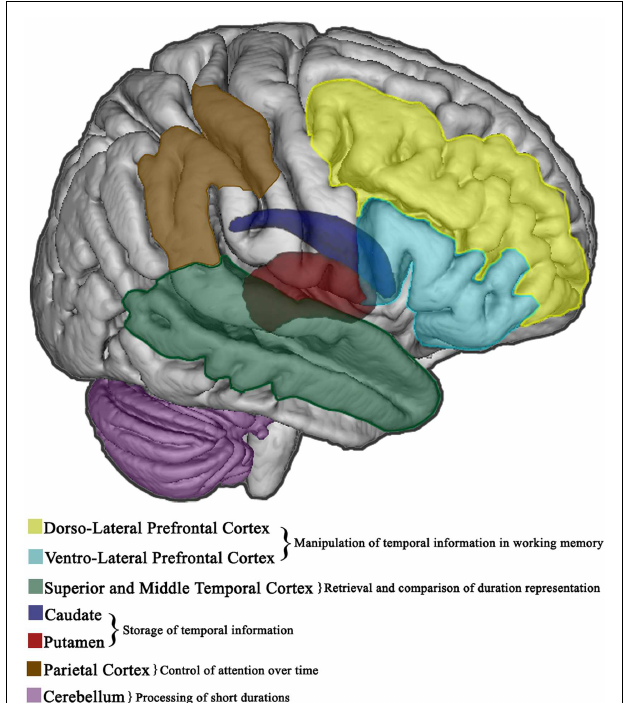
FIGURE 2 | Explicit timing in the brain . Cortical and subcortical brain regions involved in the overt estimation of elapsed time (explicit timing). The functional role of different areas in the diverse information processing stages is also specified.